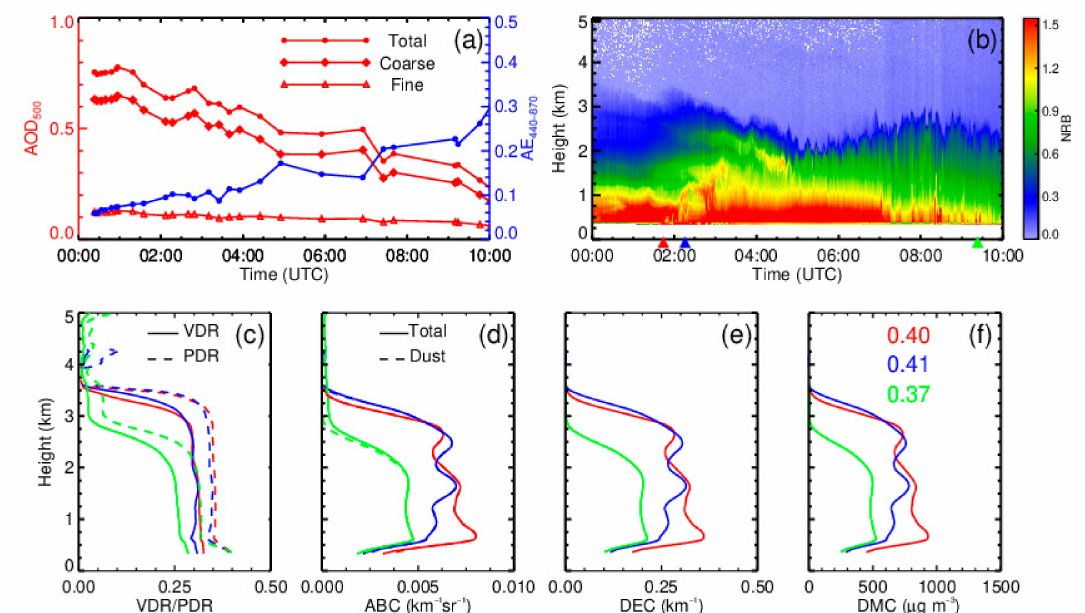
Figure 5. Time series of ( a ) the total, coarse-mode, and fine-mode AODs at 500 nm observed by the sun-photometer and ( b ) the NRB profile observed by the MPL at Dunhuang_LZU site on 24 April 2012. Vertical profiles of ( c ) VDR and PDR, ( d ) total and dust ABC, ( e ) DEC, and ( f ) DMC at 01:36, 02:08, and 09:15 which are labeled with the corresponding color triangles on the horizontal axis in ( b ). The corresponding dust MEE is also labeled in ( f